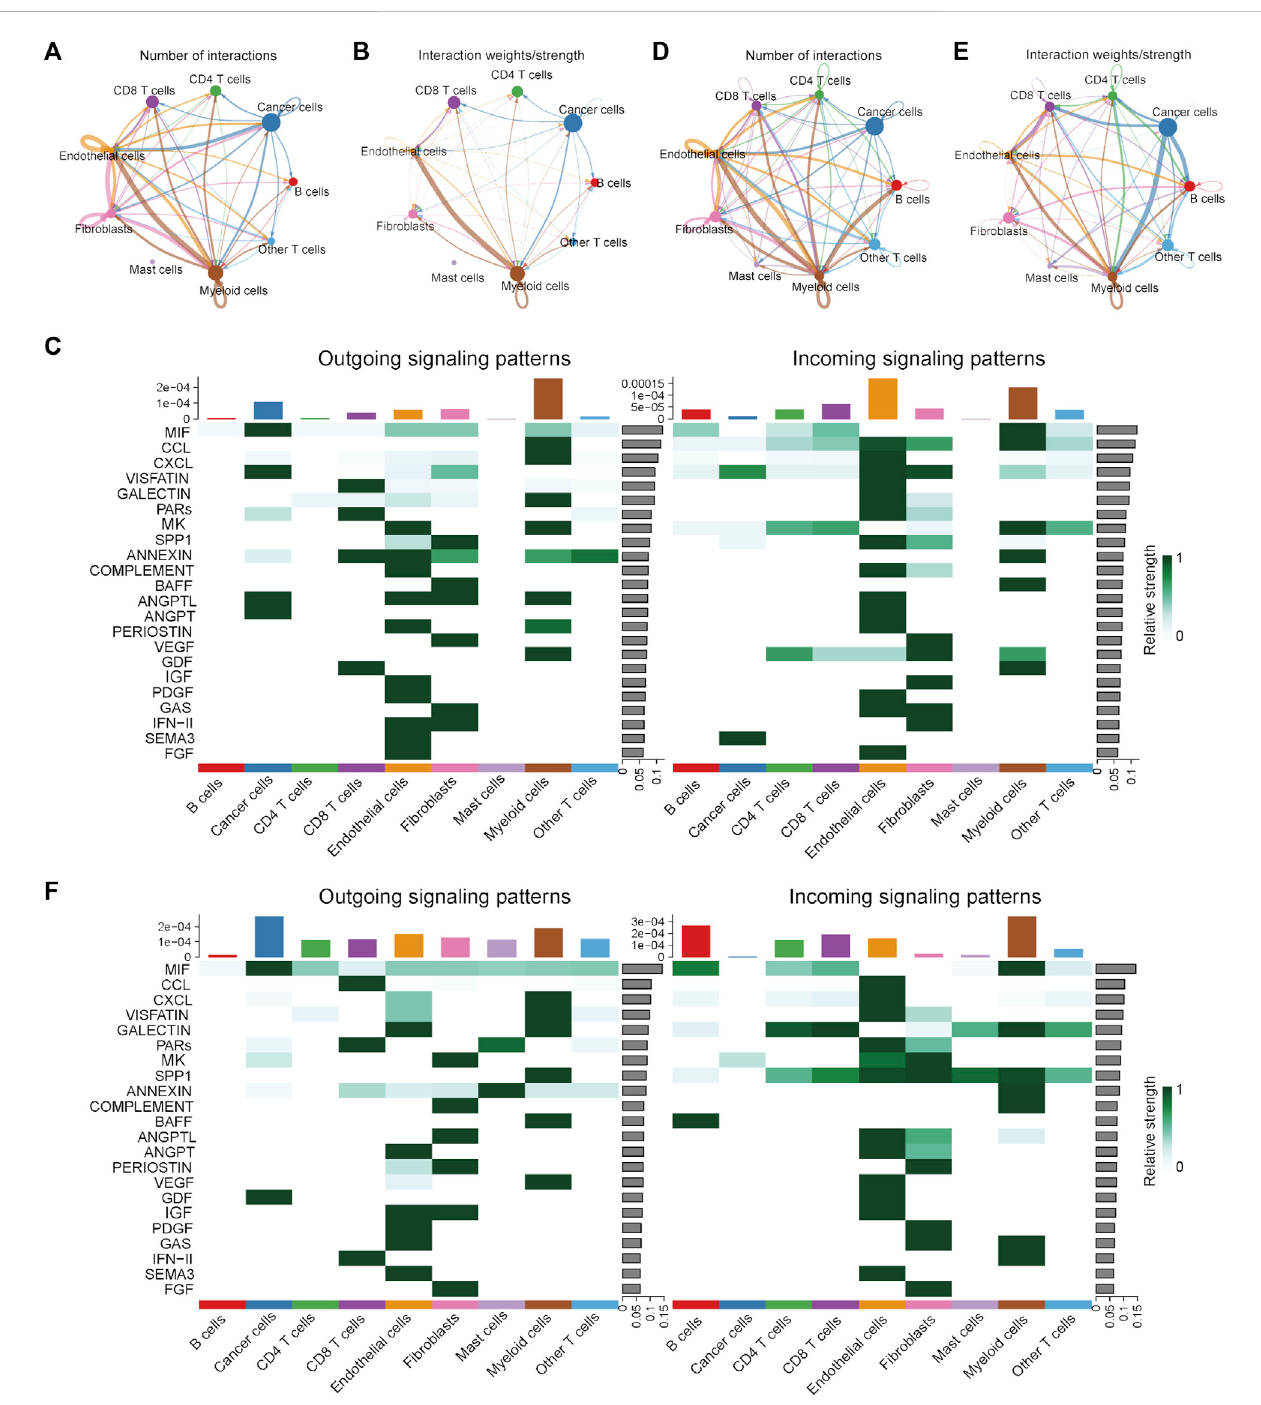
FIGURE 2 Visualization of cell-cell communication results in the scRNA training cohort. (A) Number of interactions among the nine cell types in the MSI group. (B) Interaction strength among the 9 cell types in the MSI group. (C) The potential incoming and outgoing signaling pathways among the 9 cell types in the MSI group. (D) Number of interactions among the9 cell typesin theMSS group. (E) Interaction strength among the 9 cell types inthe MSS group. (F) The potential incoming and outgoing signaling pathways among the 9 cell types in the MSS